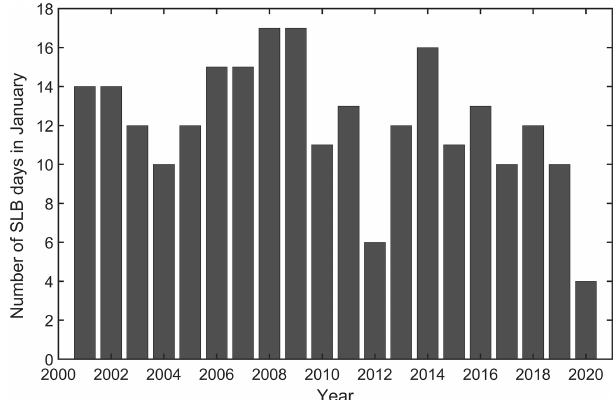
Figure 3. Number of SLB days in January from 2001 to